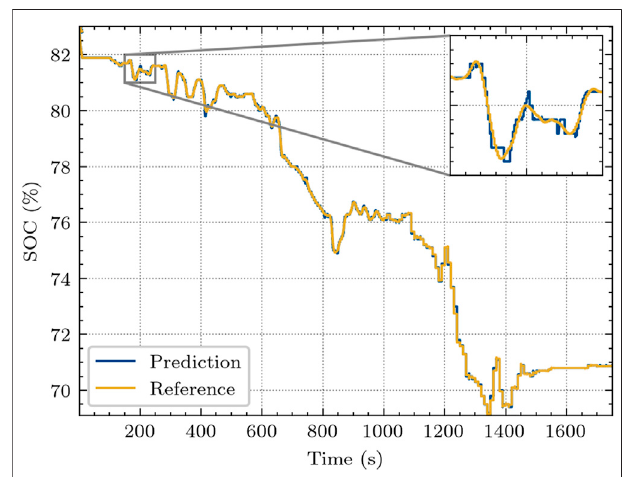
FIGURE 5 | State of Charge (SOC) during a dynamic 30-minute city